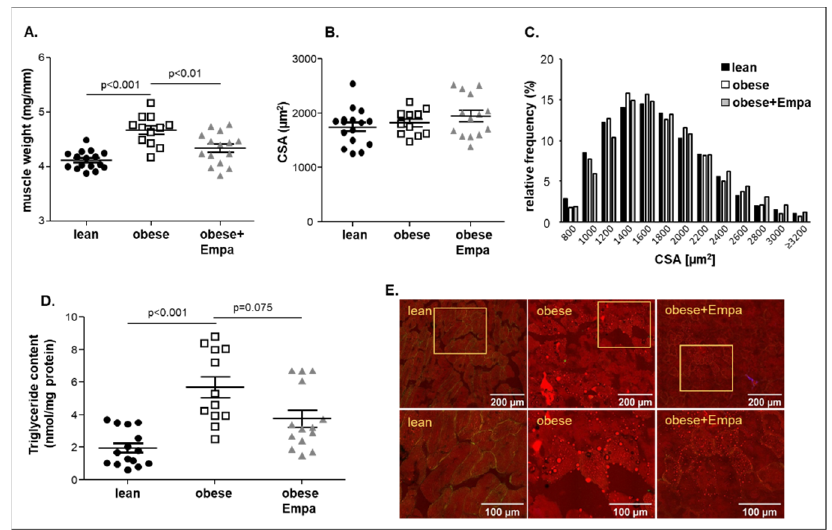
Figure 1. Muscle wet weight of the soleus muscle normalized to tibia length ( A ), cross-sectional area (CSA) ( B , C ) and triglyceride content ( D ) of the soleus muscle was measured in ZSF1-lean (lean, black circles), ZSF1-obese (obese, open squares) and ZSF1-obese rats treated with empagliflozin (obese + Empa, grey triangle) ( n = 11–15 per group). Results are expressed as mean ± SEM. In addition, NLOM (nonlinear optical microscopy) pictures ( E ) to visualize fat deposition (red staining) in the quadriceps muscle of all three groups are shown.